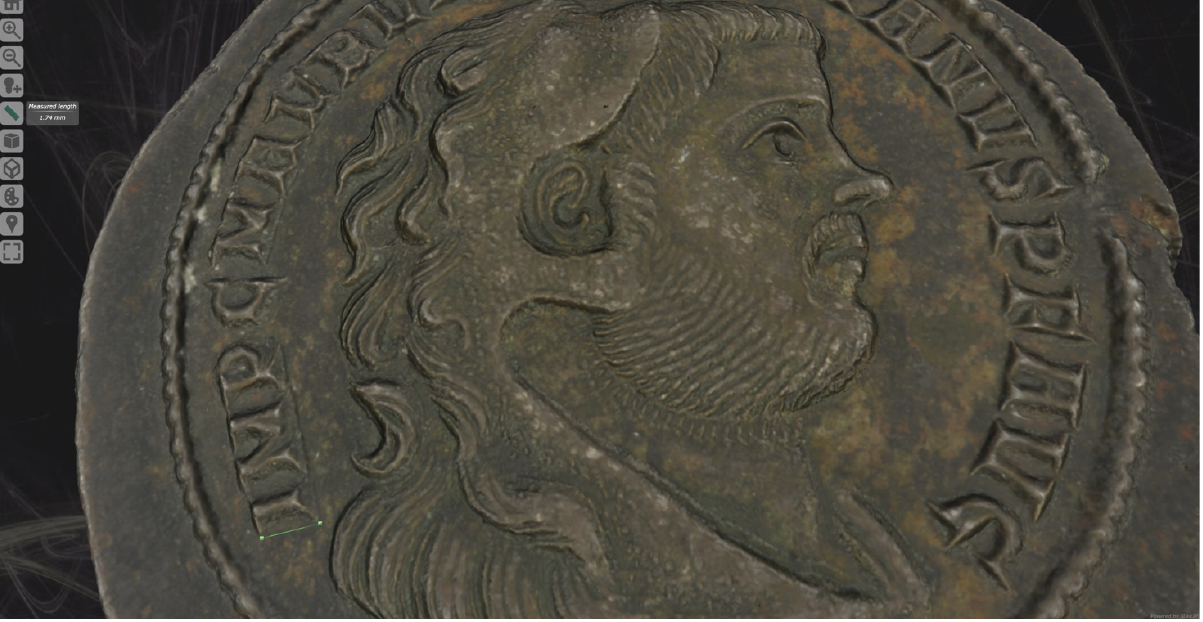
Figure 4. The photogrammetric mesh of the roman emperor Maximianus Herculeus’ medallion, with photorealistic texture, within the 3D web viewer 3DHOP. On the left of the figure all the tools configurated to interact with the 3D model.